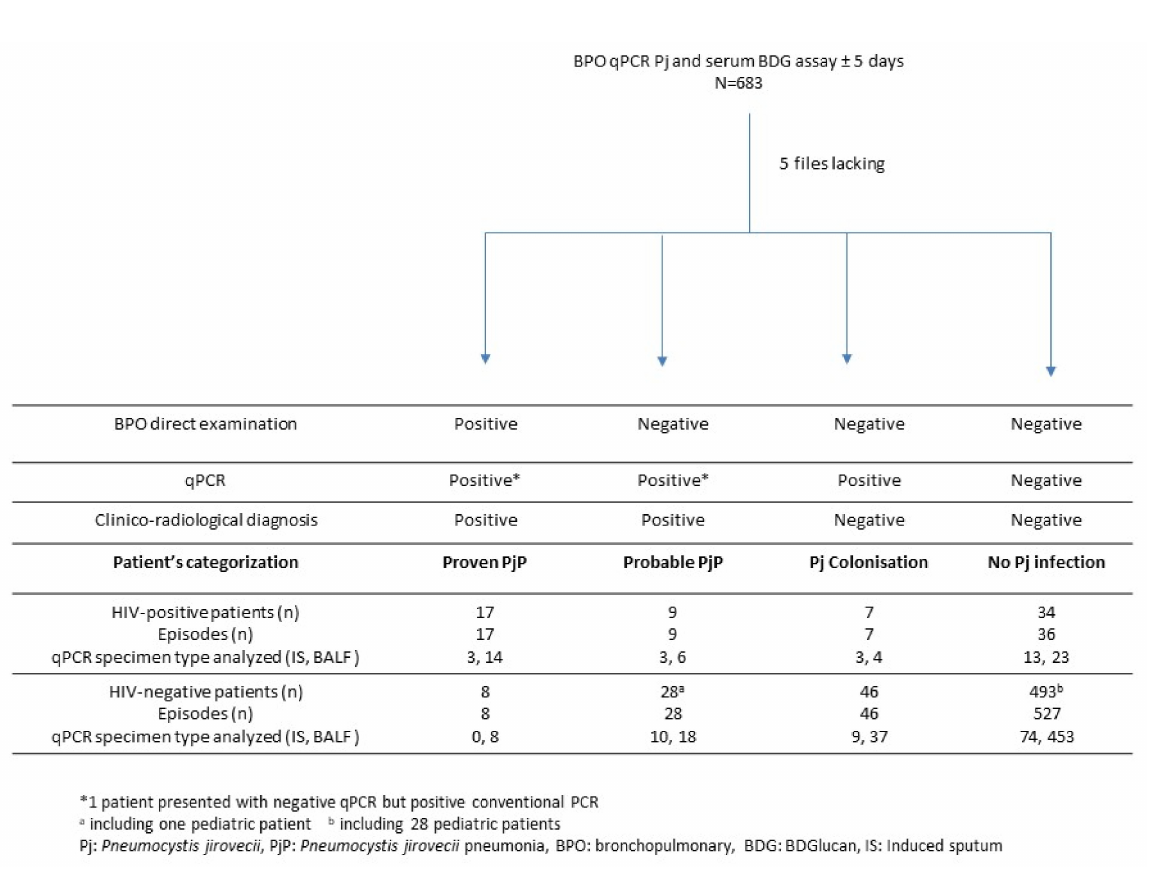
Figure 1. Characteristics and classification of patients/episodes included in the